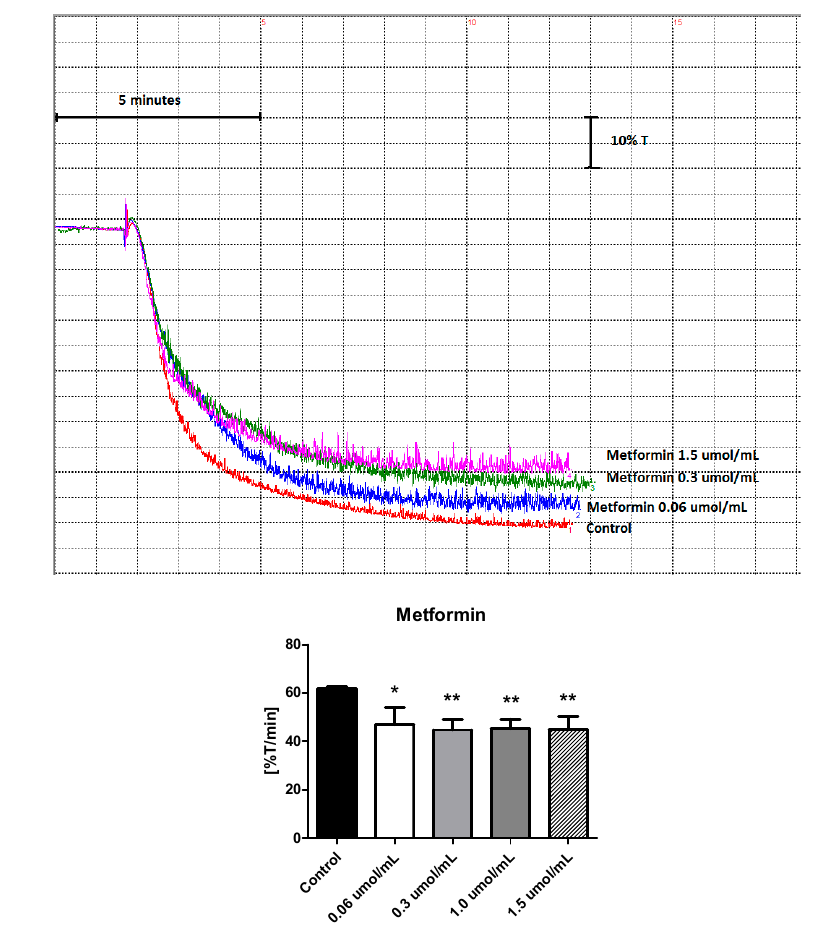
Figure 6. In vitro e ff ect of biguanide derivatives on ADP-induced platelet aggregation. ( A ) The e ff ects of compounds 1 – 4 on the initial platelet aggregation velocity ( V 0 ). The results are presented as mean ± SD, n = 4–5. * p < 0.05; ** p < 0.01; *** p < 0.001. In the case of compound 3 at the concentration of 0.3 µ mol / mL, the p -value was 0.059. Two-way Anova analysis found 1.0 µ mol / mL compound 1 to possess the most significant inhibitory e ff ect on platelet aggregation. ( B ) The e ff ect of metformin on the representative curve of platelet aggregation (left): 1-control, 2-metformin at 0.06 µ mol / mL, 3-metformin at 0.3 µ mol / mL, 4-metformin at 1.5 µ mol / mL. The bold line represents 5 min and 10% of transmittance (T). The e ff ect of metformin on the initial platelet aggregation velocity ( V 0 ) (right). The results are presented as mean ± SD, n = 4–5. * p < 0.05; ** p < 0.01.